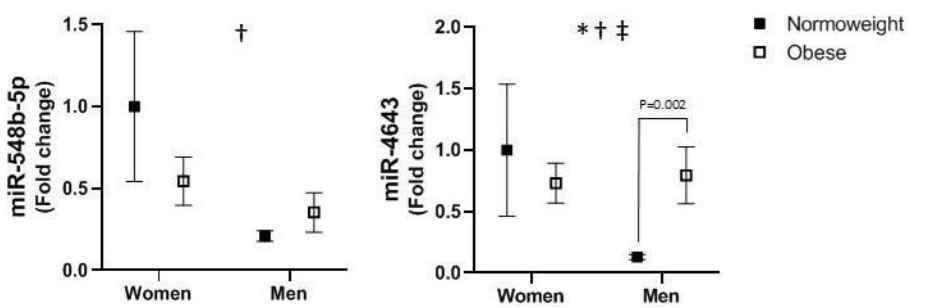
Figure 3. Visceral adipose tissue expression levels of microRNAs in women and men as a function of obesity. Data are expressed as means ± SEM and were submitted to multivariate and univariate general linear models introducing groups of subjects and obesity as independent variables. * p < 0.05 for the significant difference between normal-weight and obese subjects. † p < 0.05 for the difference between women ’ s and men ’ s cases. ‡ p < 0.05 for the difference between the interaction of obesity and sex.